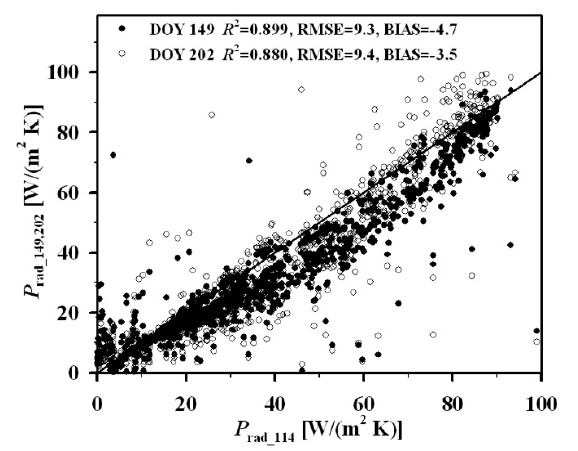
Figure 1. Relationships among the values of P for different atmospheres under clear rad days but for the same wind speed observations from the measurements at the Yucheng station on 24 April 2010 (Data are from the simulation by ALEX under different vegetation cover and soil water content conditions for each atmosphere, and atmosphere forcing on three representative days was measured at the Yucheng station on 24 April (DOY 114), 29 is May (DOY 149), and 21 July (DOY 202) 2010, which can be found in Appendix. P rad − T calculated by simulated H and T s a